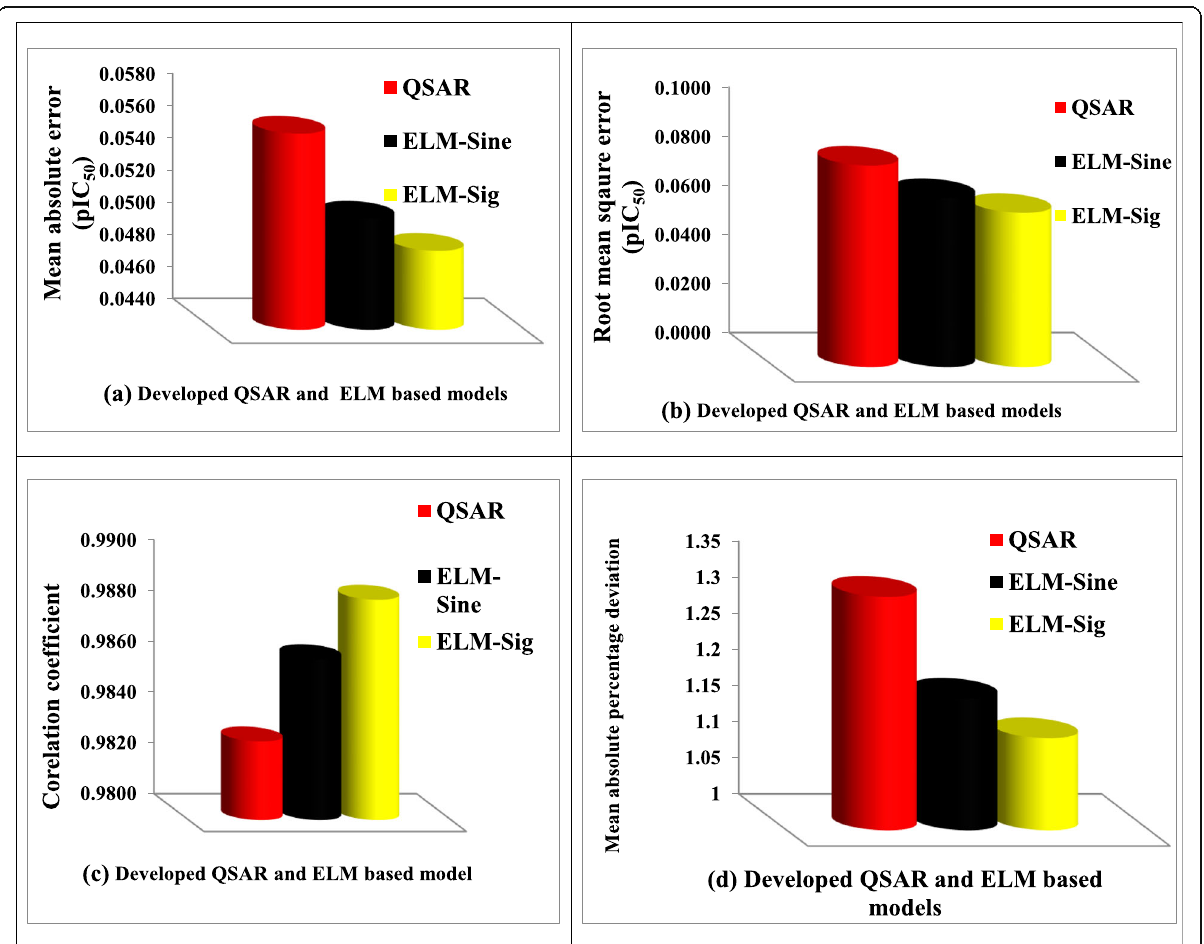
Fig. 5 Comparison of the performance of the developed models using ( a ) MAE, ( b ) RMSE, ( c ) CC, and ( d ) MAPD performance measuring